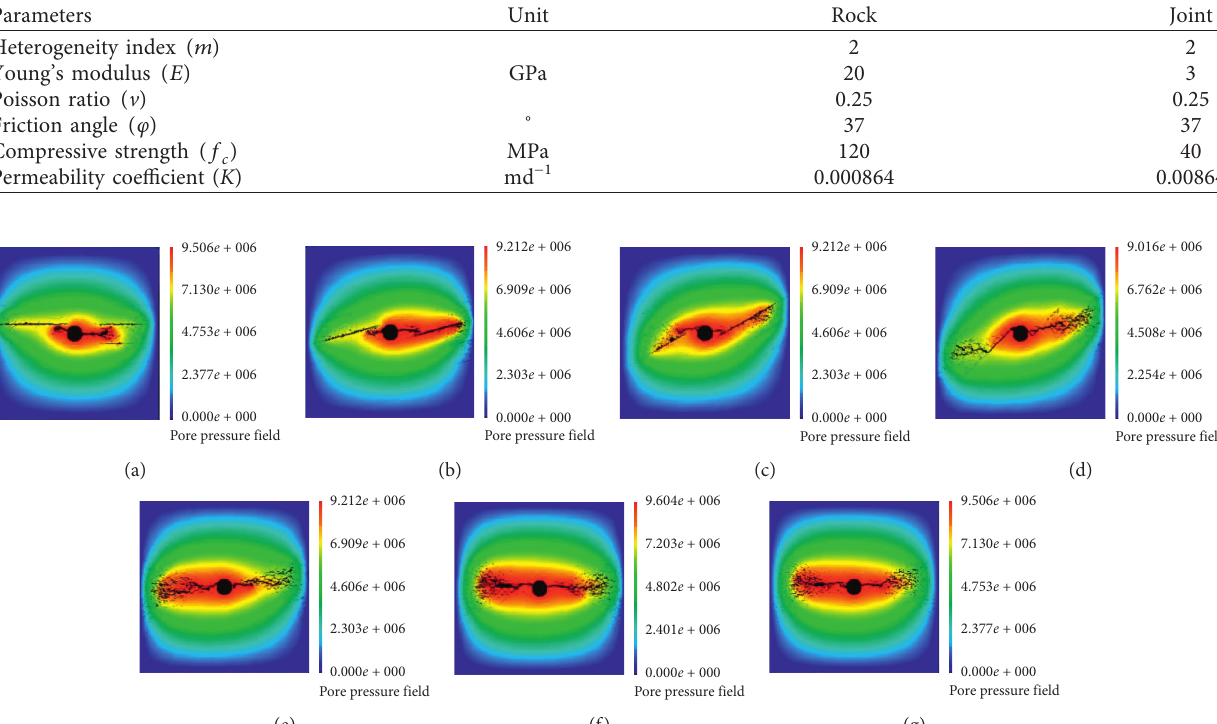
� 10MPa, σ � 5MPa). (a) α � 0 ° , (b) α � 15 ° , (c) α � 30 ° , H V